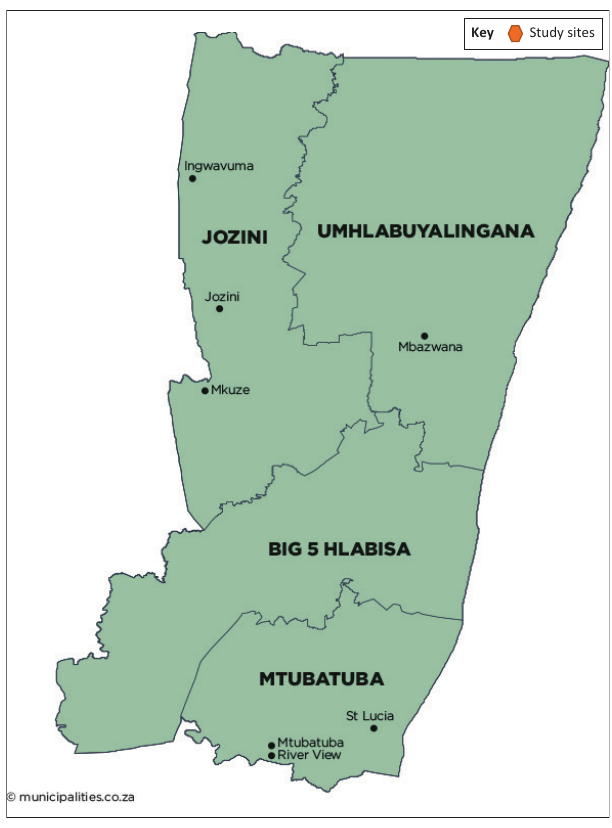
FIGURE 2: Jozini local